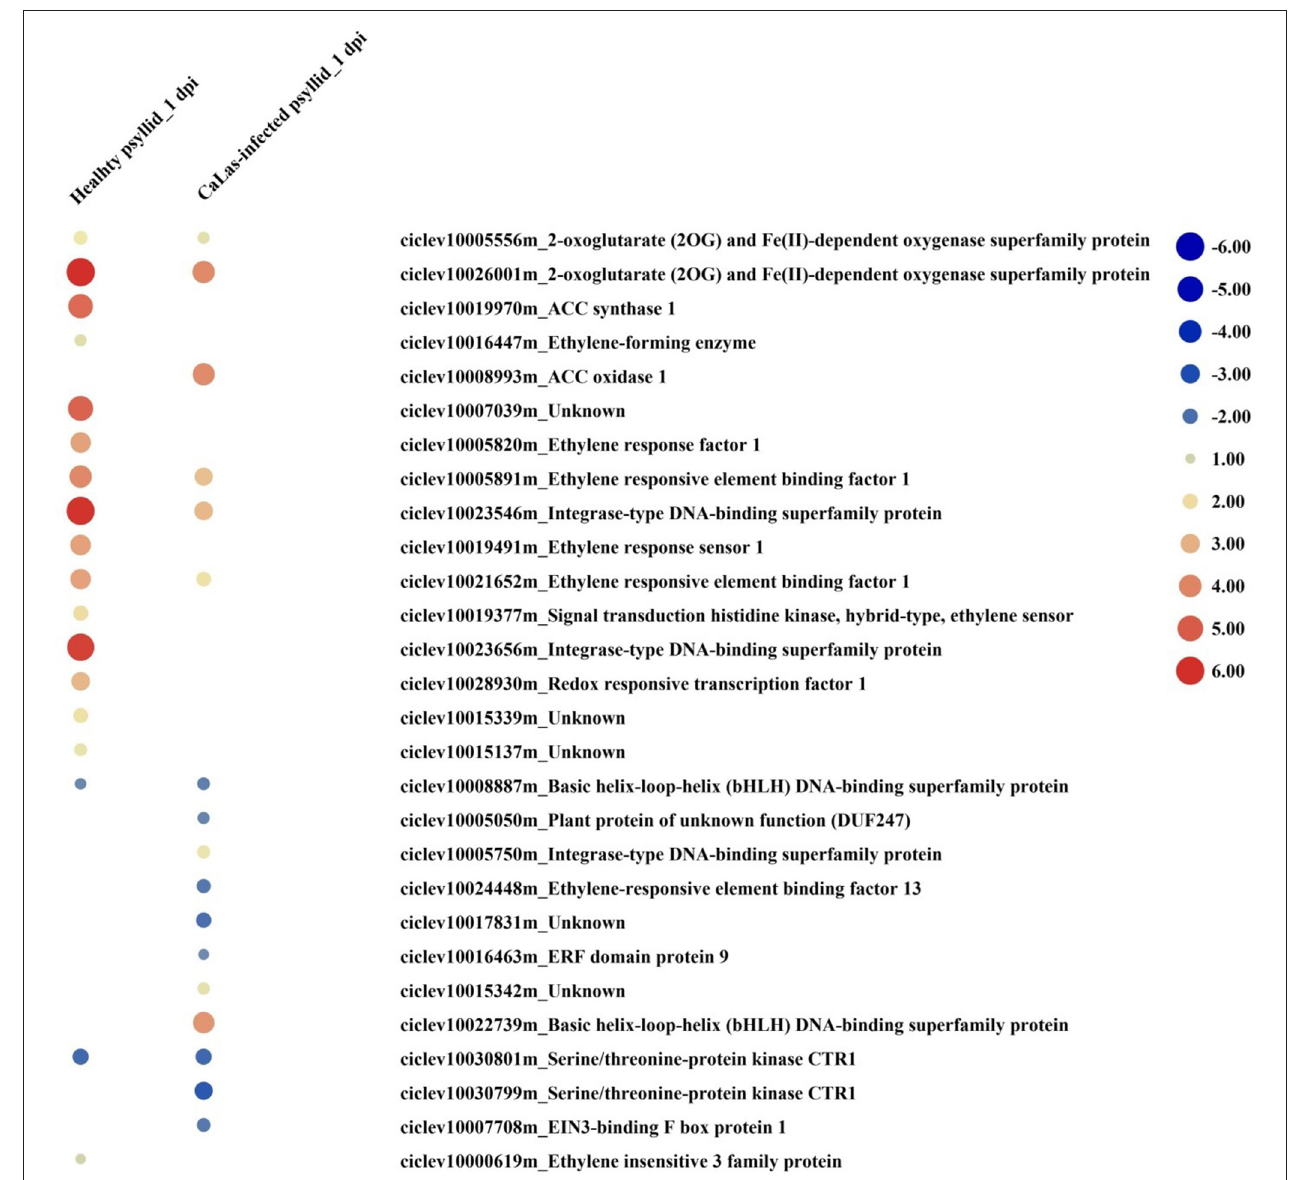
FIGURE 6 | The red-blue heatmap of modulated DEGs involved in ethylene signaling pathways. Each DEG is depicted by a color signal where red signifies upregulation and blue signifies downregulation. The size of each spot indicates the level of